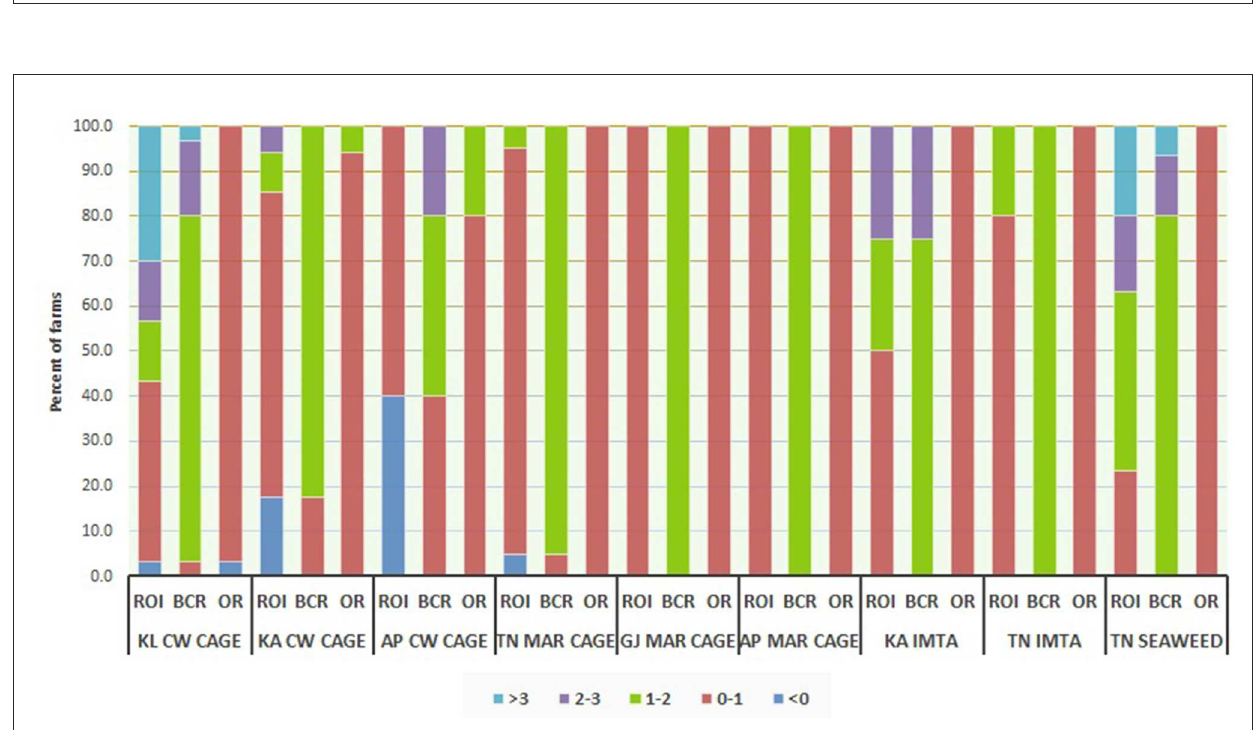
FIGURE4 Distribution of economic viability indicators of sample farms. For seaweeds, profitability indicators are reported for a batch of 10 rafts each for the sample farmers. KL CW CAGE: Coastal water cage, Kerala; KA CW CAGE: Coastal water cage, Karnataka; AP CW CAGE: Coastal water cage, Andhra Pradesh; TN MAR CAGE: Marine cage, Tamil Nadu; GJ MAR CAGE: Marine cage, Gujarat; AP MAR CAGE: Marine cage, Andhra Pradesh; KA IMTA: IMTA, Karnataka; TN IMTA: IMTA, Tamil Nadu; TN SEAWEED: Seaweed, Tamil